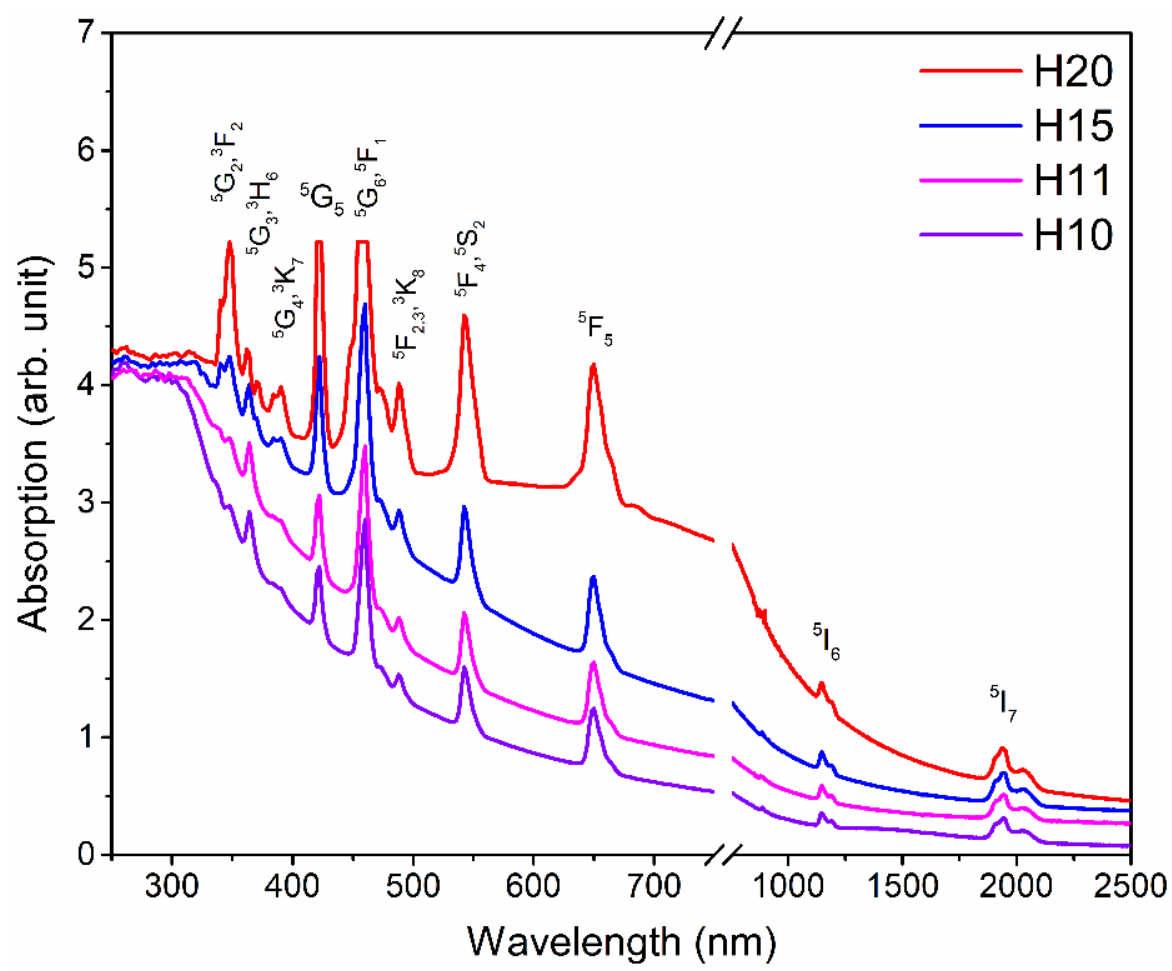
Figure 6. Absorption spectra of Ho-SiAlON samples.